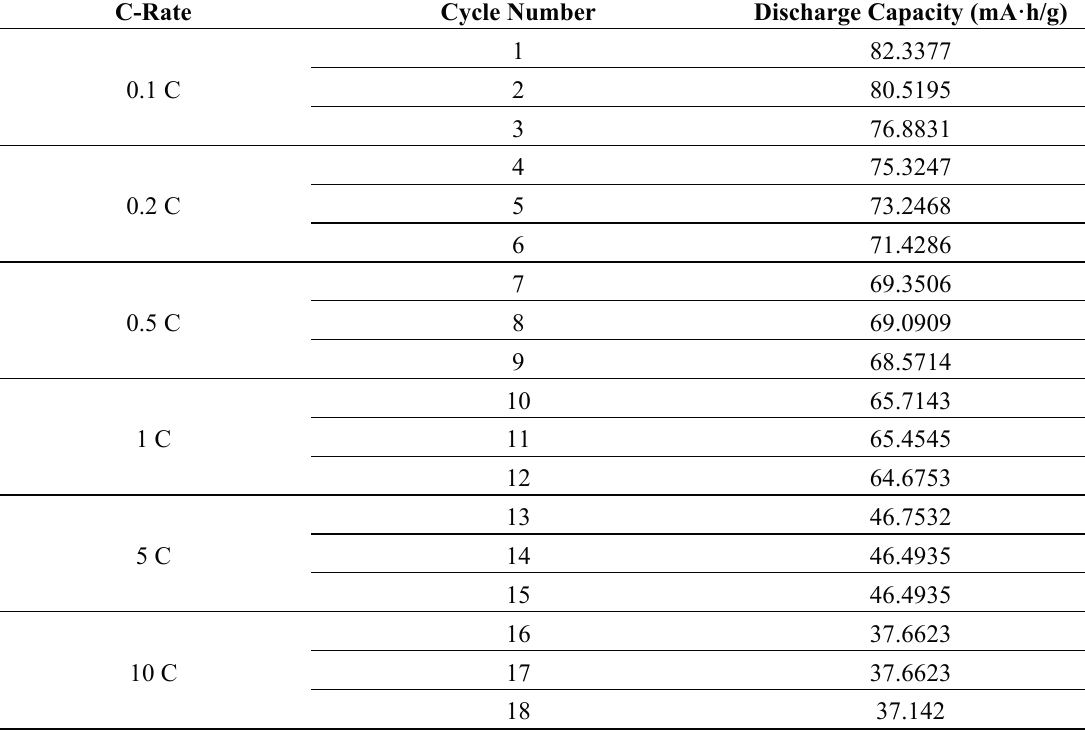
Figure 10. Maximum unit cumulative capacity curve in various cycles of coin cell discharge tests. Table 6. Maximum unit cumulative capacity in various cycles of coin cell discharge